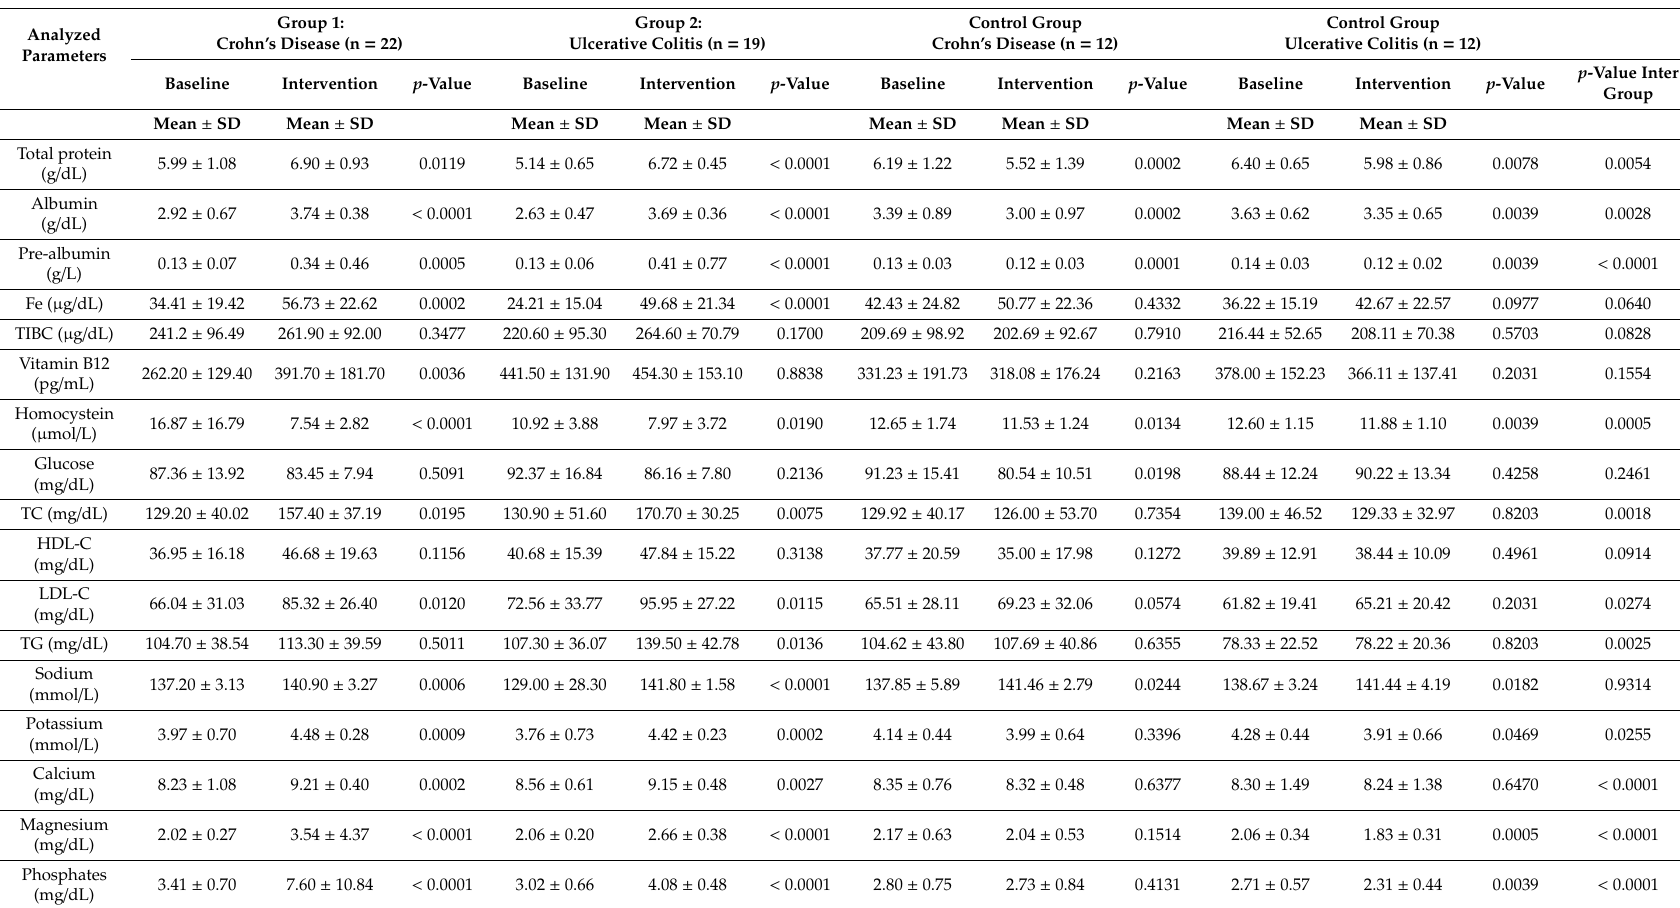
Table 4. The changes during the combined enteral and parenteral nutrition in selected nutritional parameters in IBD patients (n = 65). Analyzed